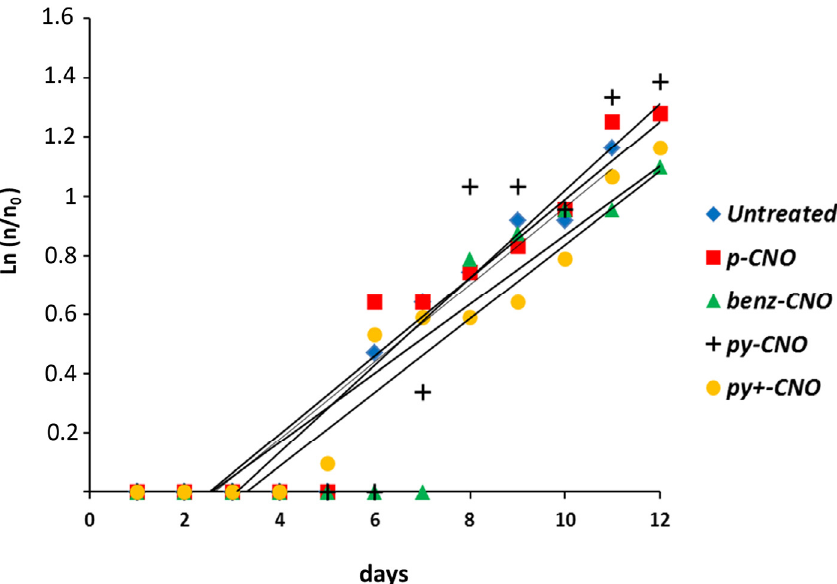
Figure 6. Effect of CNOs on the asexual reproductive potential of Hydra. Five Hydra founders, untreated or incubated for 24 h with 0.05 mg/mL of CNOs, were washed out and monitored every day for bud growth and detachment. The graph shows n / n 0 values at each time point. No significant differences in the growth rate between treated and untreated animals was observed, indicating the absence of CNO toxicity on a long term